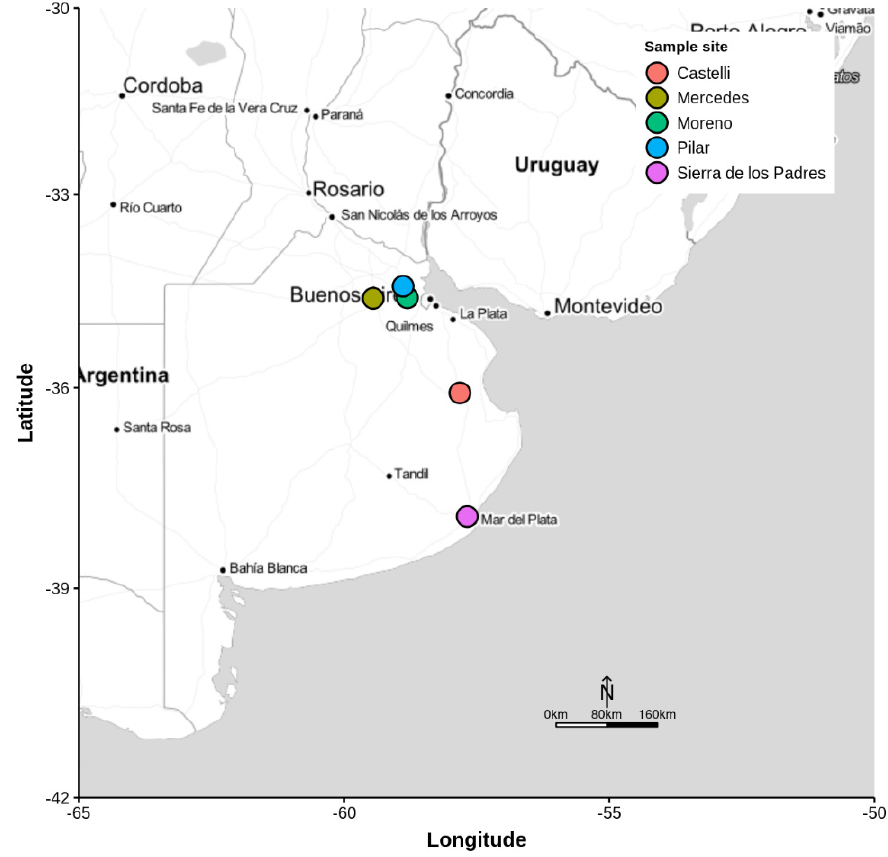
Figure 2. Map of the sampling sites for collecting both robber-fly egg-clusters and scarab larvae.